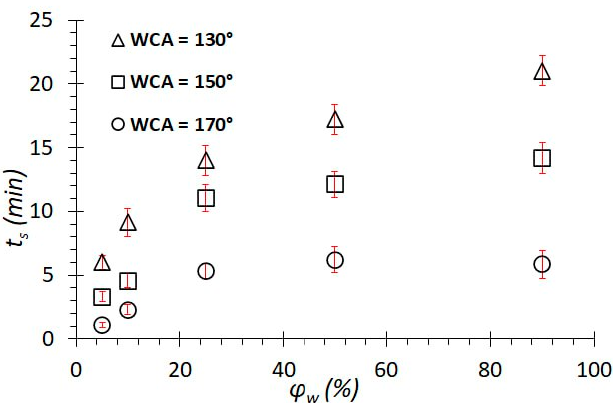
Figure 5. Dependence of the separation time on the concentration of water in the emulsion for coatings with different wetting contact angles.